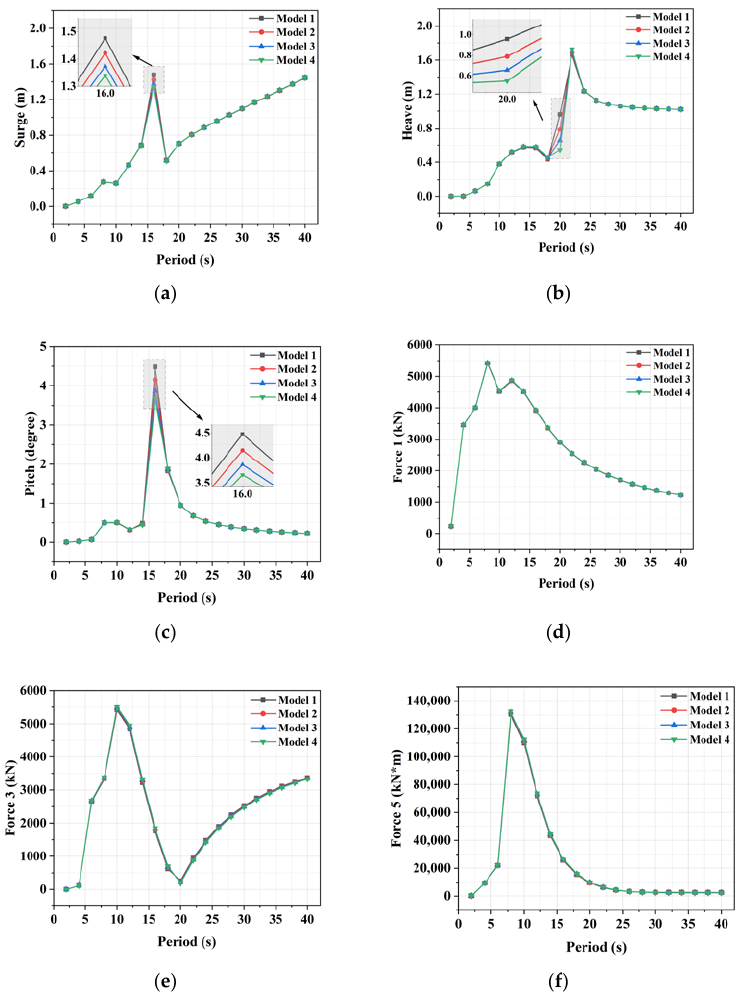
Figure 4. The comparison of the RAOs of the different mesh models in the 0-degree wave direction: ( a ) RAOs of surge motion; ( b ) RAOs of heave motion; ( c ) RAOs of pitch motion; ( d ) RAOs of Force 1; ( e ) RAOs of Force 3; ( f ) RAOs of Force 5.